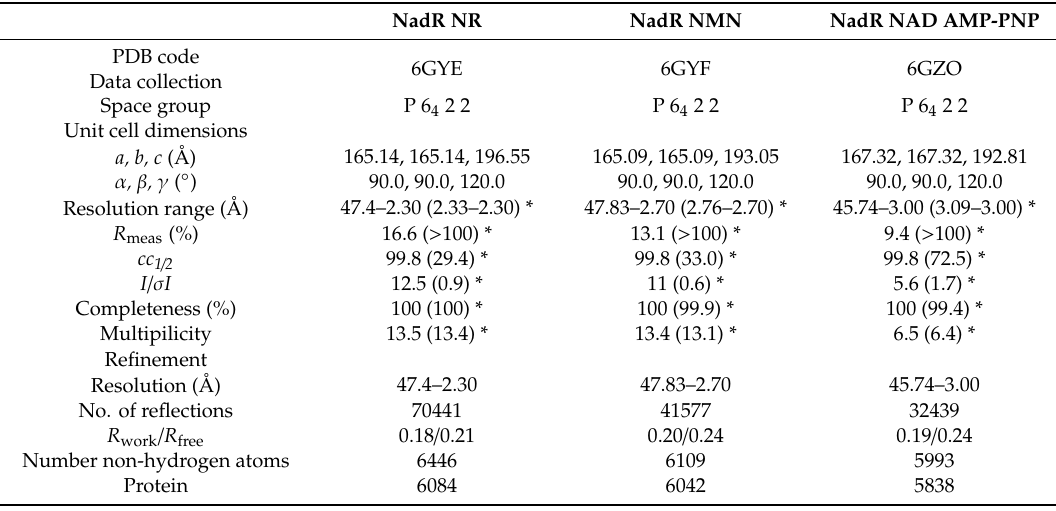
Figure 6. Crystal structure of NadR Ll . ( A ) Overall fold in secondary structure cartoon representation, NMN adenylyltransferase (NMNAT) domain in red and ribosylnicotinamide kinase (RNK) domain in yellow; unresolved loops are shown as dashed lines. ( B ) Superposition of NadR Ll with NadR from H. influenzae (cyan, the substrate from this structure is shown as sticks), the movements of the nicotinamide-recognition loop and one of the helixes forming the binding site are shown with red arrows; rmsd ~ 2.5 Å; ( C ) ATP-binding site in the RNK domain: the position of the lid loop is indicated within a dashed rectangle; a sulfate ion likely occupies the position of one of ATP phosphates; essentially conserved Lys and Asp residues of Walker A and B motifs are shown as sticks (numbering from NadR Ll , with NadR HI numbers in brackets); ( D ) A possible binding site at the interface between the domains: NAD, AMP-PNP, and the protein residues forming this binding site are shown as sticks. The omit electron densities for these cofactors, as well as NR and NMN, are shown in Supplementary Figure S2. Table 4. Data collection and refinement statistics for the NadR Ll crystal structures with respective